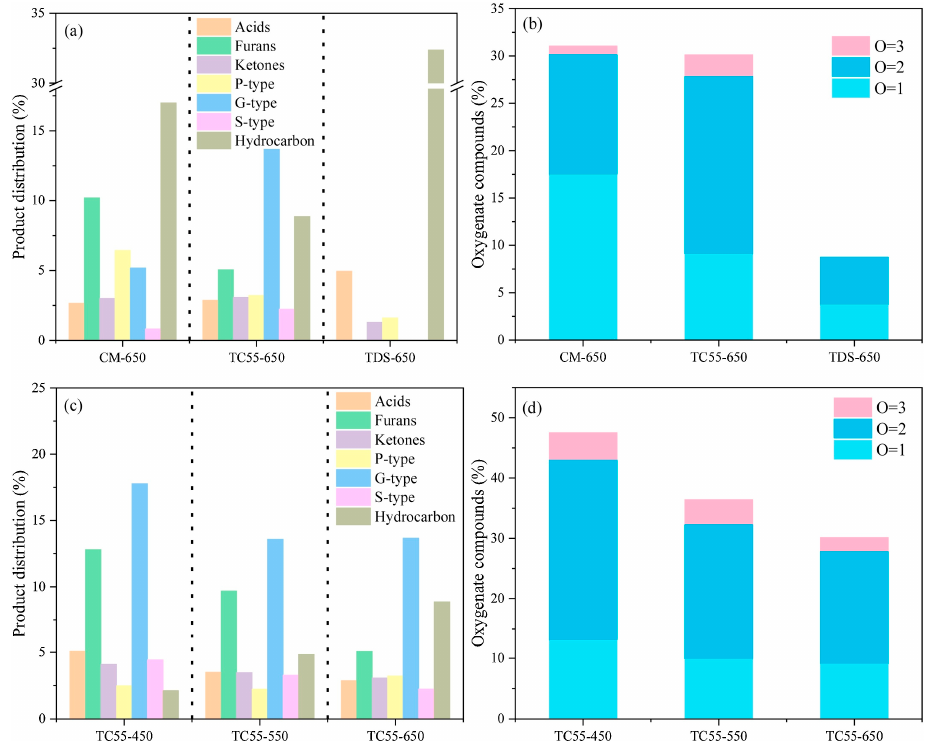
Figure 6. Cattle manure (CM), Textile dyeing sludge (TDS) and co-pyrolysis in equal proportion (TS55) product distribution at 650 ° C ( a ) at varying temperatures ( c ), oxygenated compounds at 650 ° C ( b ), and varying temperatures ( d ) [79]. Copyright 2022, Elsevier.